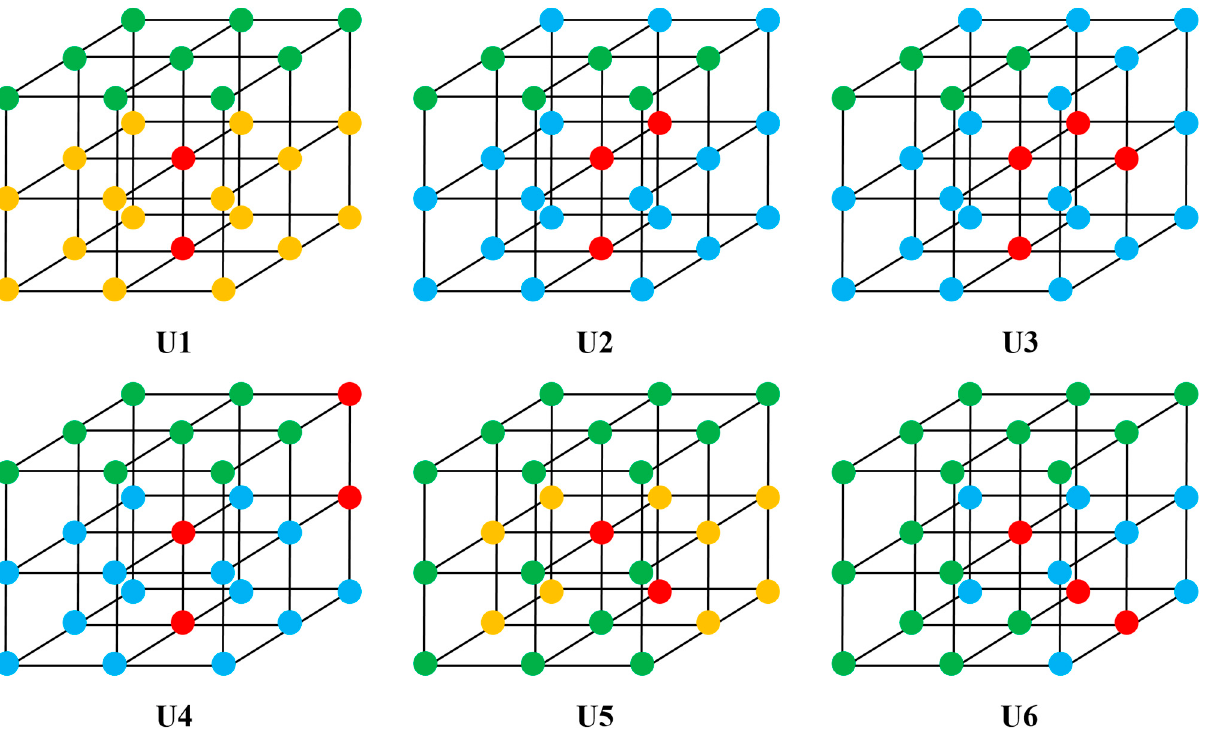
Figure 3. Six base deletion templates in the up direction. The red center point of the deletion templates is the wood voxel that needs to be judged, the remaining red points represent wood voxel, the green points represent empty voxels, the blue points indicate that the types of voxels do not need to be considered, and the yellow points indicate that at least one of them is a wood voxel.